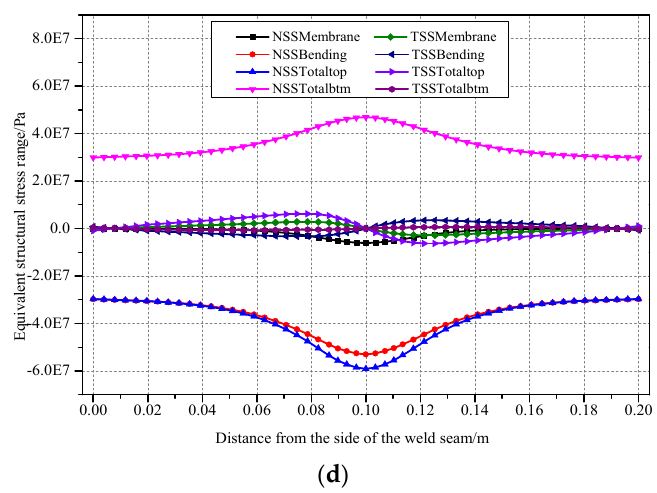
Figure 14. Equivalent structural stress of the weld root and weld toe of double-sided weld seams. ( a ) Equivalent structural stress of Double-Weldline1, ( b ) equivalent structural stress of Double-Weldline2, ( c ) equivalent structural stress of Double-Weldline3, ( d ) equivalent structural stress of Double-Weldline4.